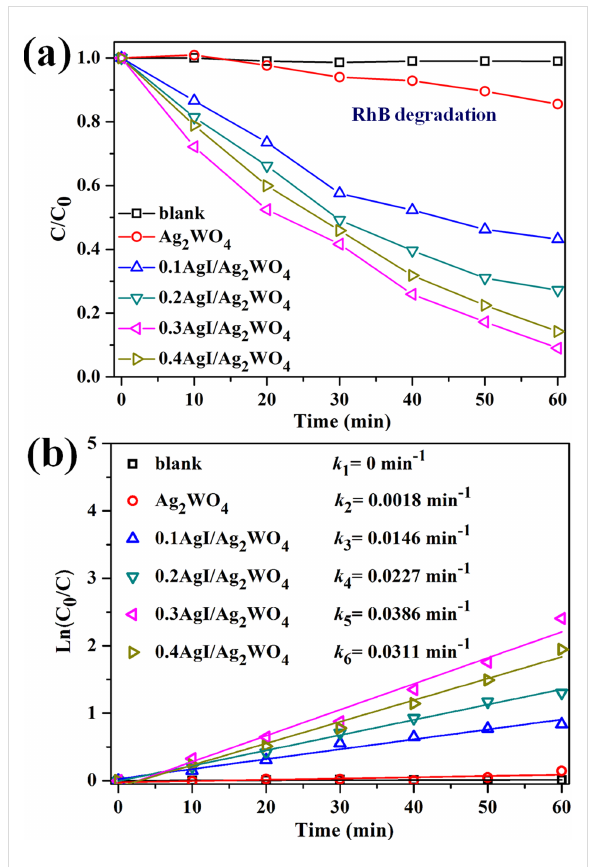
Figure 5: (a) The photocatalytic degradation and (b) degradation rate constants of RhB using different catalysts (10 mg) under visible